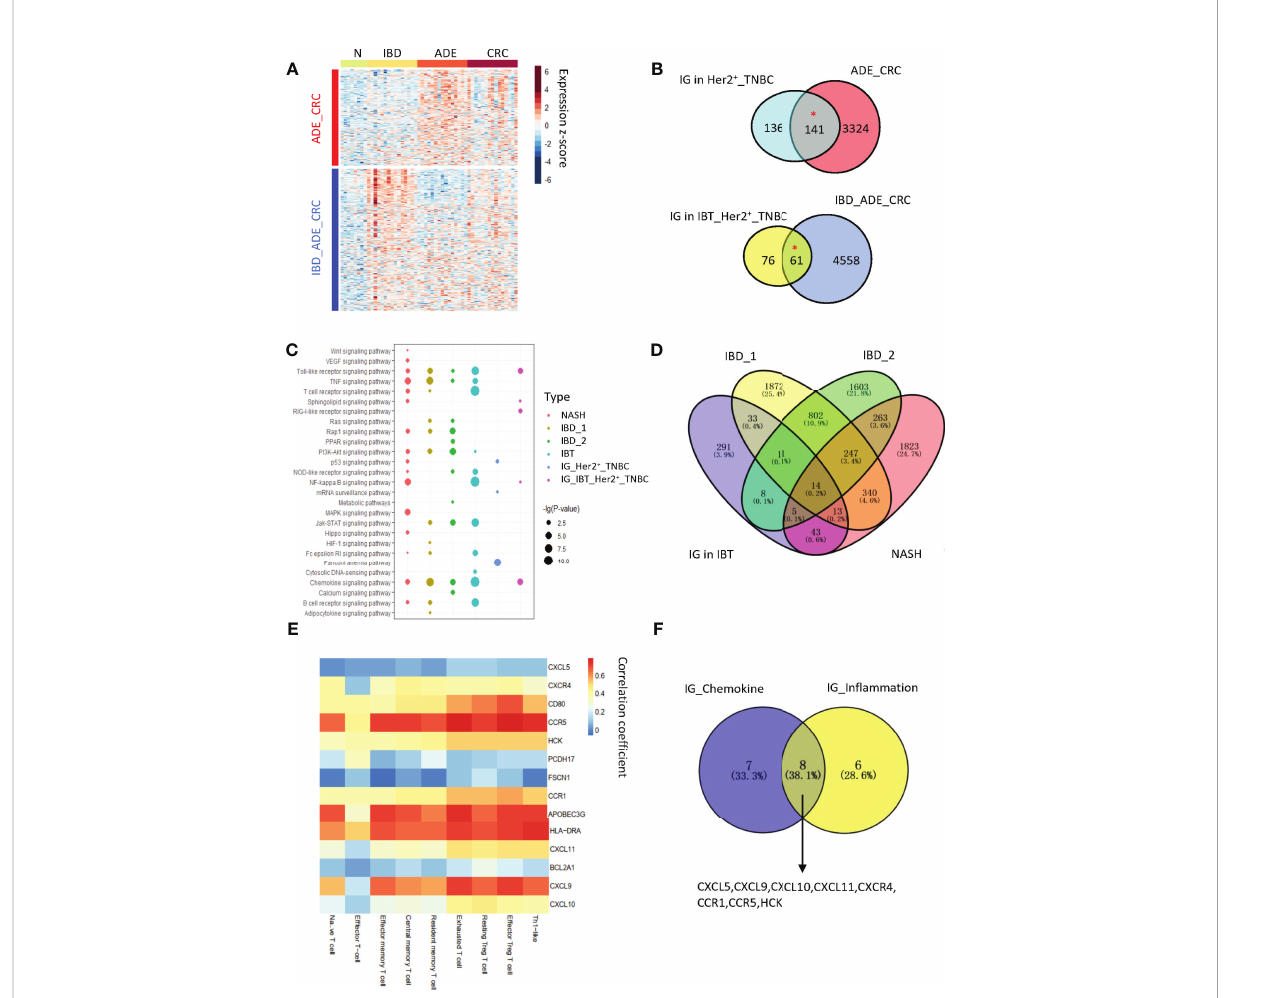
FIGURE 6 The expression of interface genes in other in fl ammatory diseases. (A) A heatmap of differentially expressed upregulated genes in the GSE4183 dataset. (B) The overlap between interface genes and differentially upregulated gene groups in IBD. “ * ” , p-value < 0.05. (C) Enrichment of signaling pathways in different in fl ammatory tissues. NASH (non-alcoholic steatohepatitis) and IBD (in fl ammatory bowel disease). IBT, in fl ammatory breast tissue; IG, interface genes. IBD_1, GSE4183; IBD_2, GSE83687; NASH, GSE162694; IG_IBT_Her2 + _TNBC, interface genes